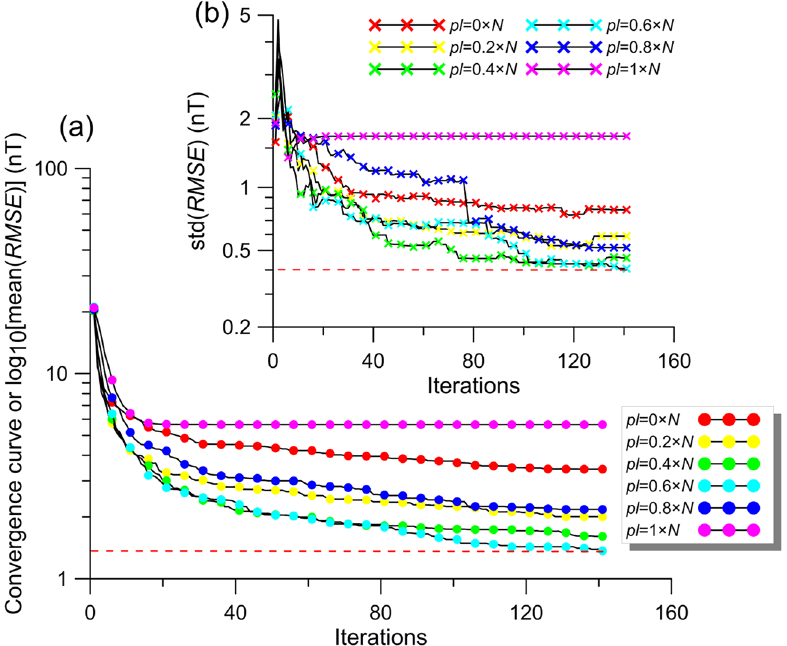
Figure 4. Analyzing the effect of various pl values. ( a ) Variation behavior of the mean RMSE values obtained via the increment of pl , ( b ) uncertainties of BMO via the variation of pl